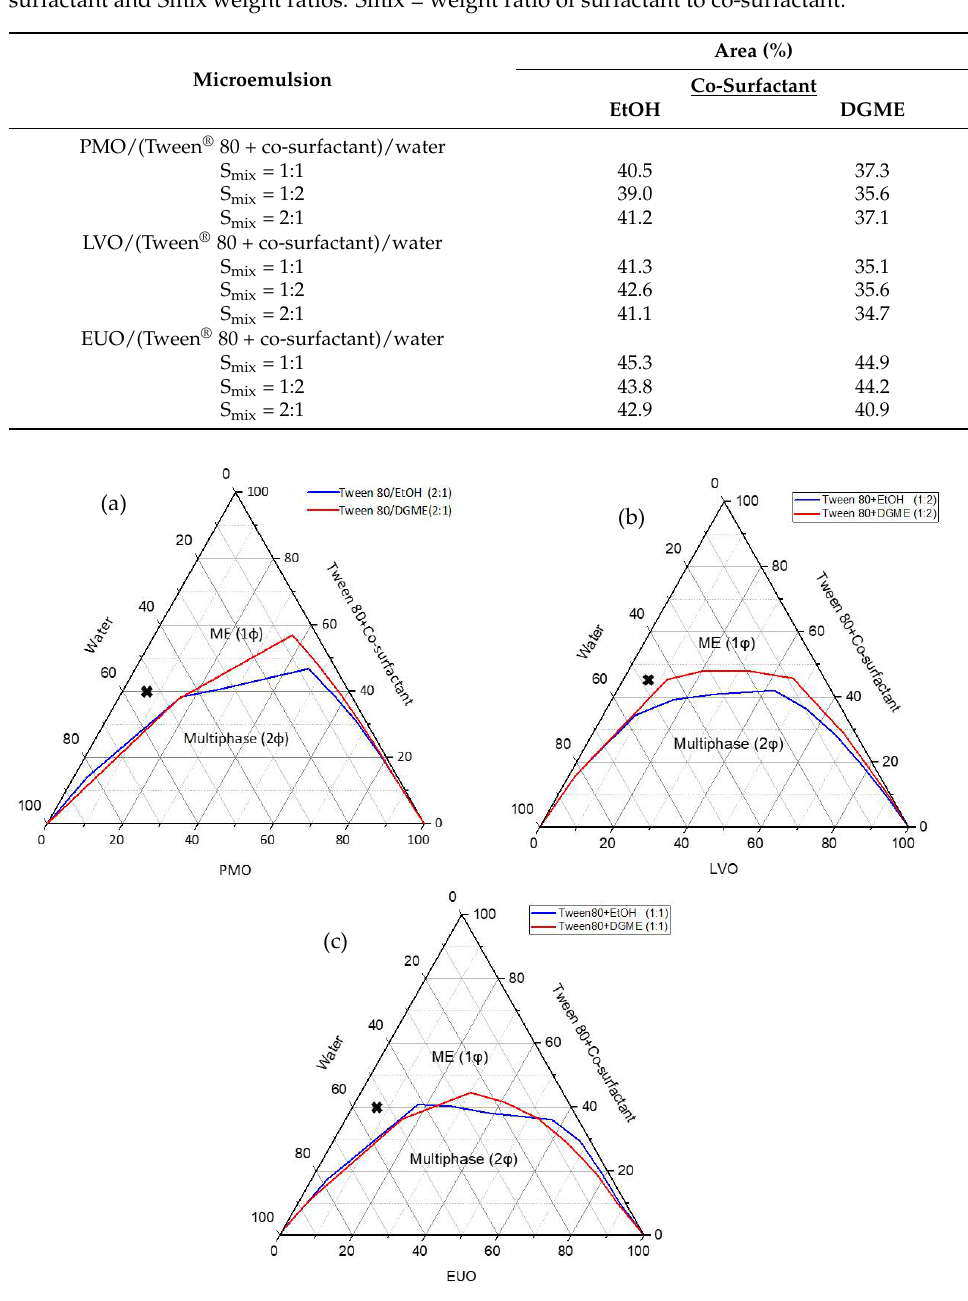
Table 2. Percentages of microemulsion area in total phase diagram for each combination of co-